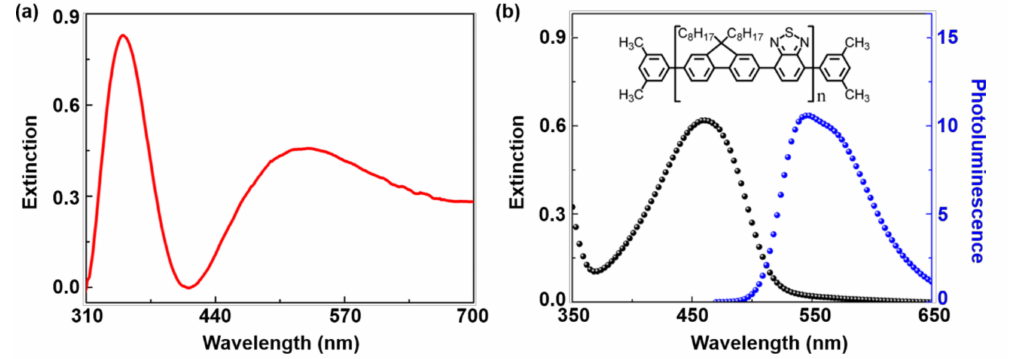
Figure 2. ( a ) Extinction spectrum of Ag NFs. ( b ) Extinction spectrum (black curve) and photoluminescence spectrum (blue curve) of F8BT membrane. Inset: the molecular structure of F8BT.